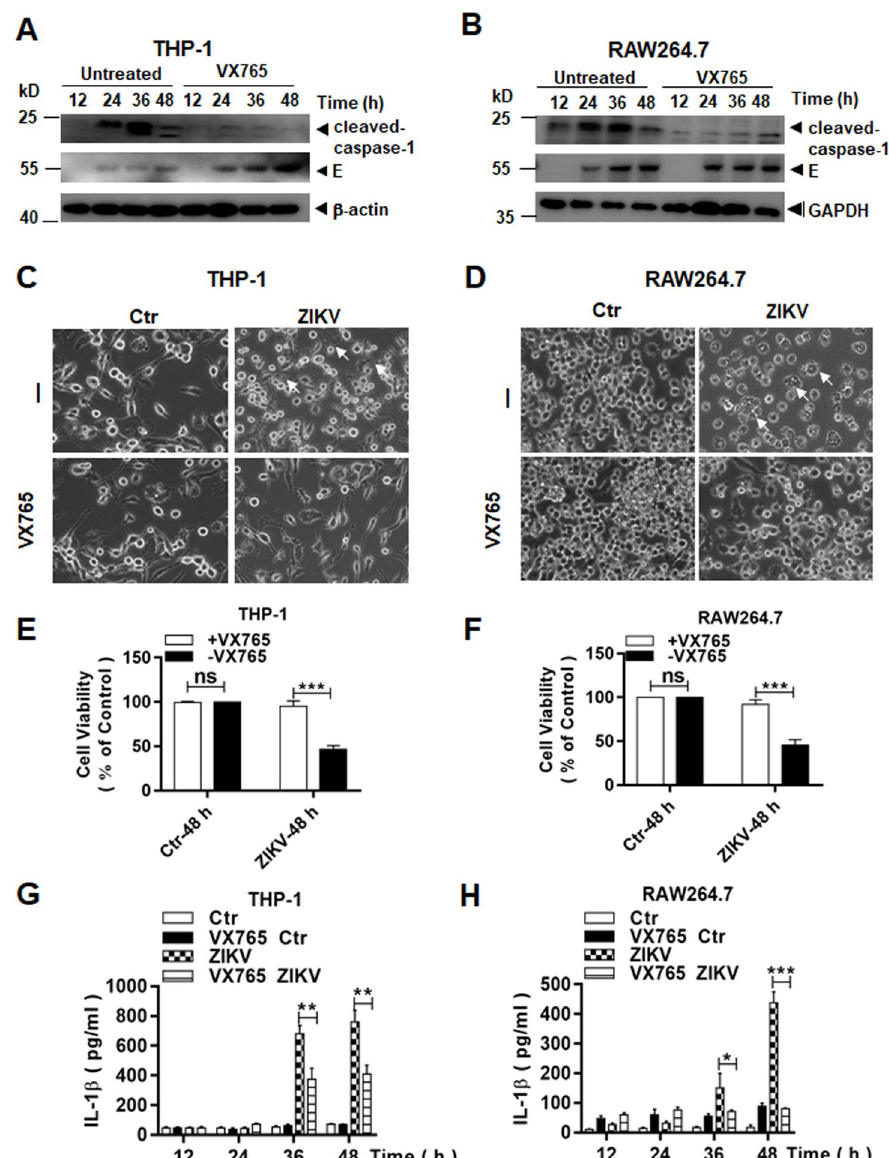
Fig 9. Pyroptosis was dependent on caspase-1 in ZIKV-infected human and murine macrophages. Cell lysates were prepared at various time points p.i. from ZIKV-infected THP-1 ( A ) and RAW264.7 ( B ) cells which were untreated or pre-treated with VX765, a caspase-1 inhibitor, at 20 μ M. The lysates were analysed by western blot analyses with an anti-cleaved caspase-1 antibody. Morphological changes were observed on ZIKV-infected THP-1 ( C ) and RAW264.7. Arrows, swollen or ruptured cells. ( D ) cells, which were untreated or pre-treated with VX765, under a light microscope (Magnification x200). ( E & F ) Cell viability of THP-1 and RAW264.7, pre-treated with or without VX765 and followed by ZIKV infection (0.1 MOI), was measured by a CCK8 assay. ( G & H ) Culture medium was sampled at various time points p.i. from ZIKV-infected THP-1 and RAW264.7 cells, which were untreated or pre-treated with VX765, for measurement of secreted IL-1 β by ELISA. The experiments were performed in triplicates and the data were shown as mean+SD and analyzed by unpaired Students t-test. � , P < 0.05; �� , P < 0.01; ��� , P < 0.001. ns, no significance.